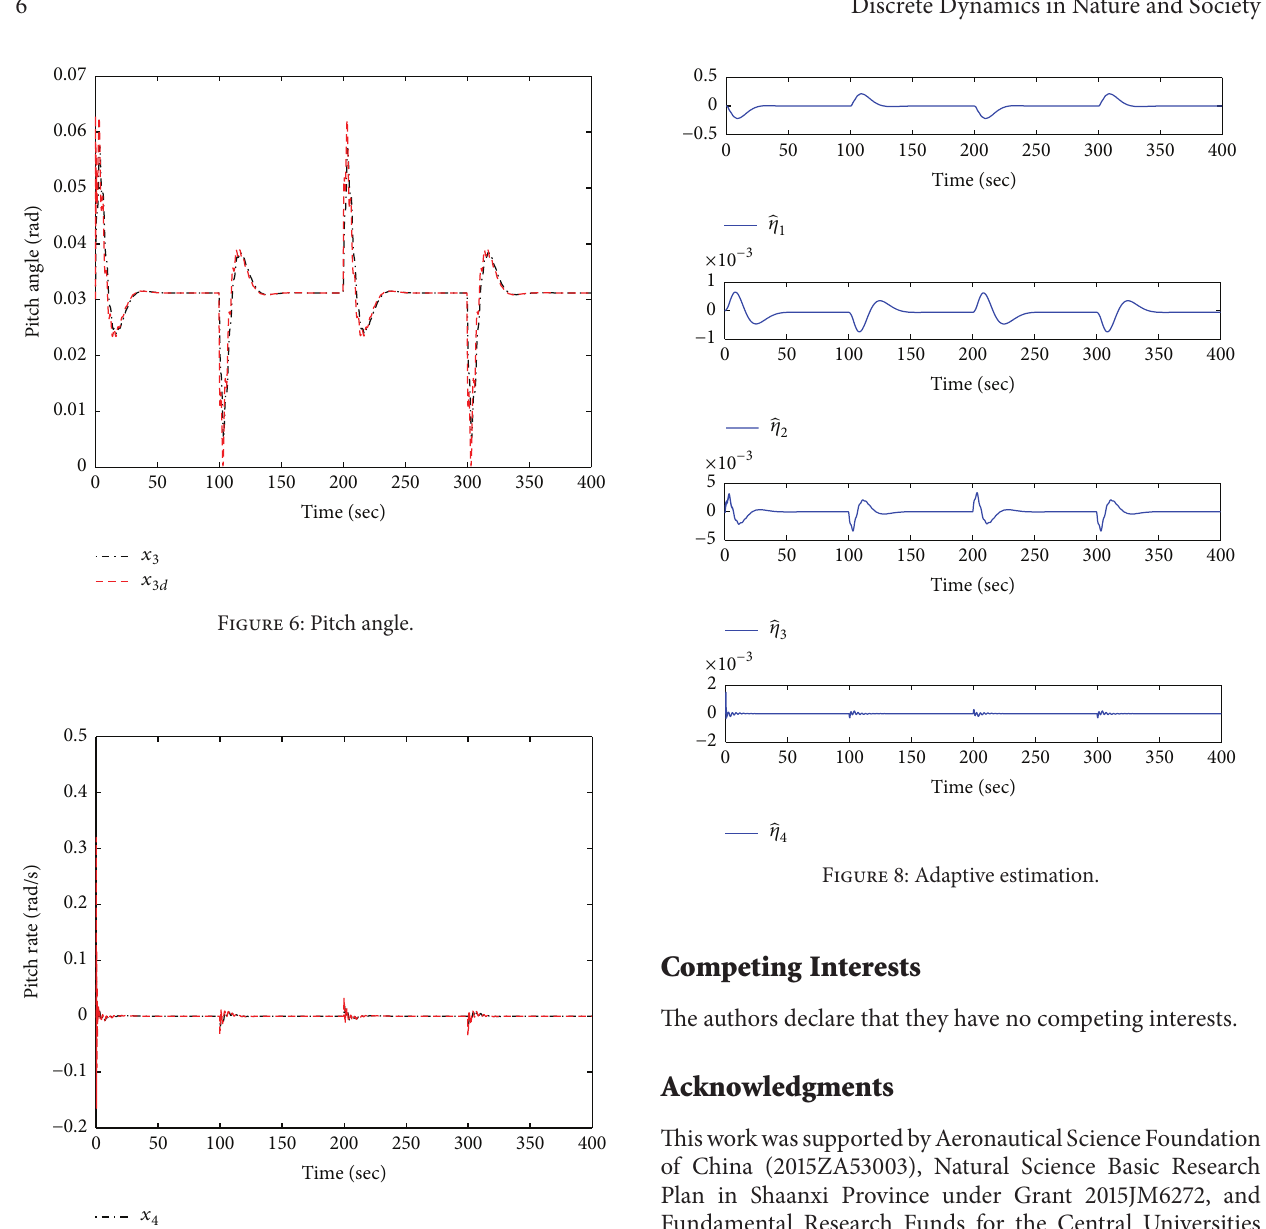
Figure 7: Pitch rate.